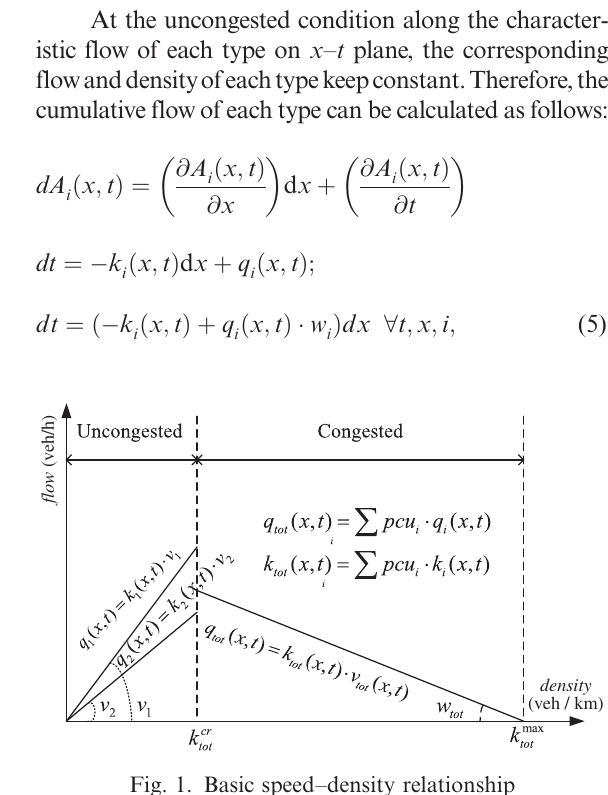
Fig. 1. Basic speed (cid:2) density